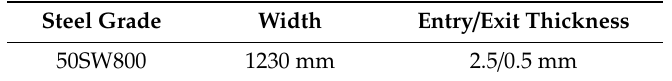
Table 3. Parameters of non-oriented silicon steel in cold rolling.